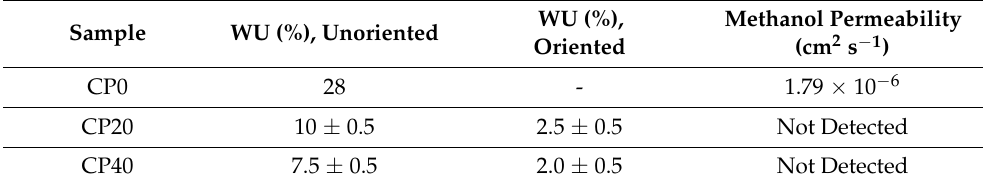
Table 3. Water uptake (%) after 72 h, and methanol permeability after 168 h, of